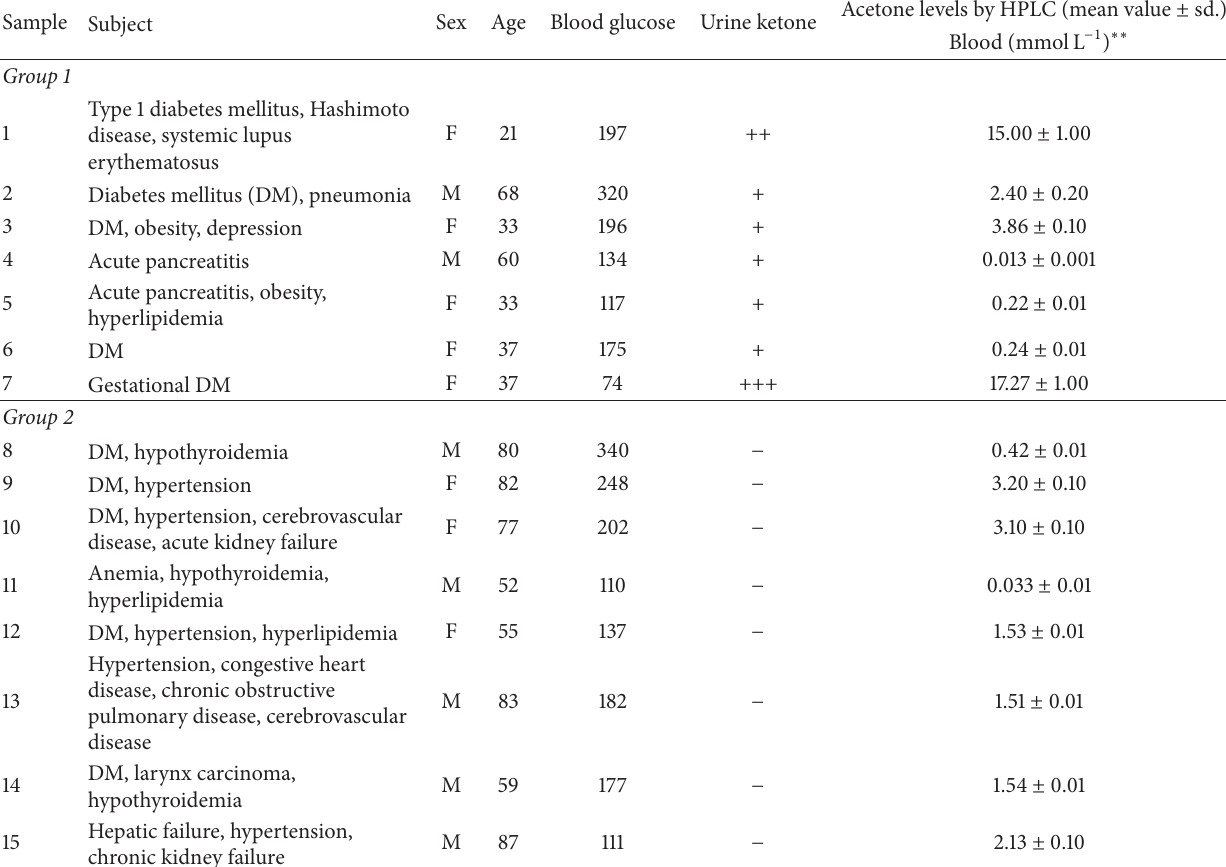
Table 1: Quantitative analysis data of acetone as its 2,4-dinitrophenylhydrazone derivative in human blood by